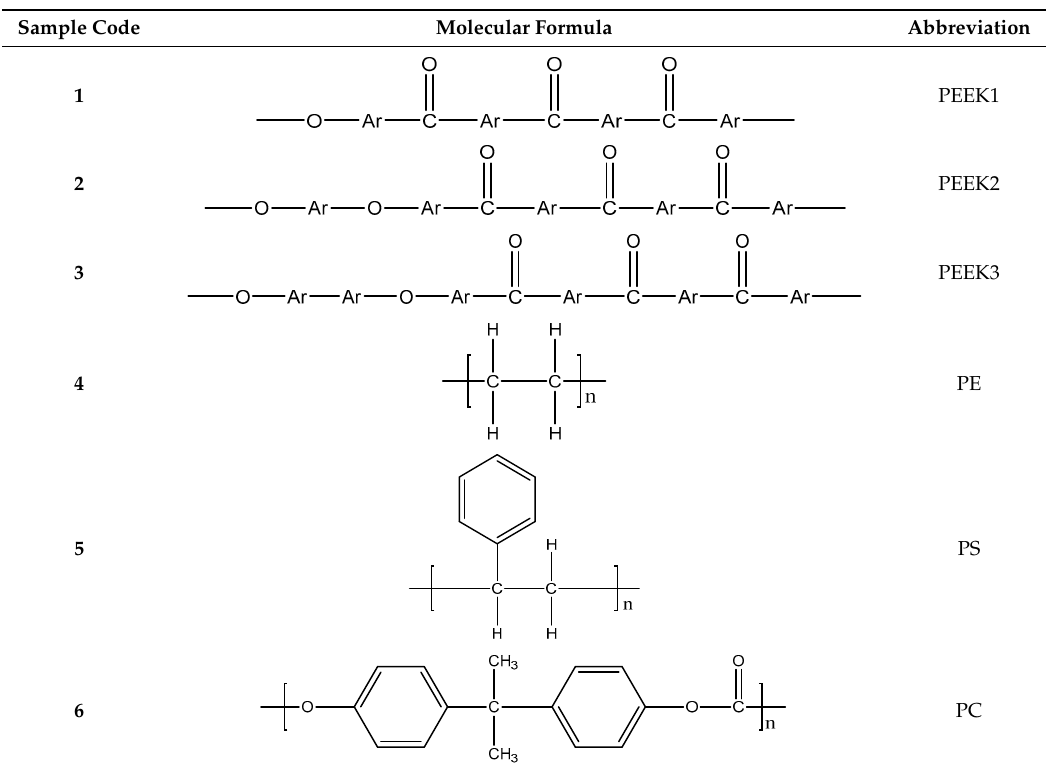
Table 1. Molecular formula of the tested polymeric materials.